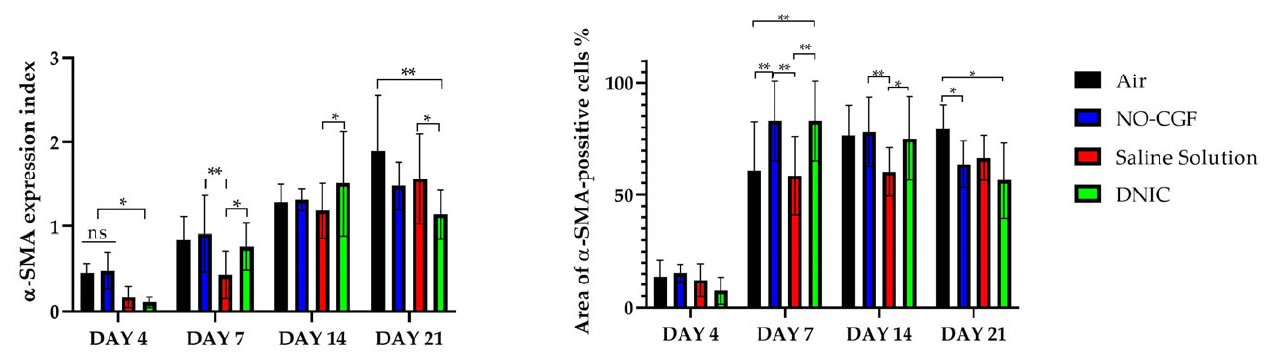
Figure 9. α -SMA expression index and area of α -SMA-positive cells, two-way ANOVA, mean values ± SD; ns—no differences, *— p < 0.05, **— p < Figure 9. α‐ SMA expression index and area of α‐ SMA ‐ positive cells, two ‐ way ANOVA, mean val ‐ ues ± SD; ns—no differences, *— р < 0.05, **— р < 0.01.